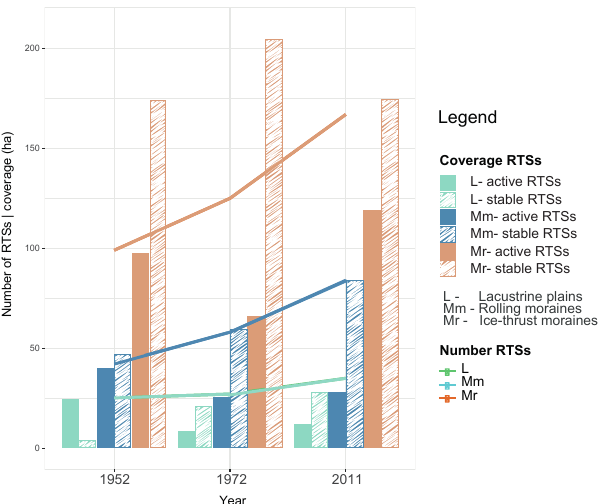
Figure 5. Graph showing the evolution in the number and areal cov- erage of retrogressive thaw slumps (RTSs) between 1952 and 2011 for each geologic units (L, lacustrine plains; Mm, rolling moraines; Mr, ice-thrust moraines). The y axis shows both variations in the number of RTSs and variations in the areal coverage of RTSs (ha), which differentiate between active and stable